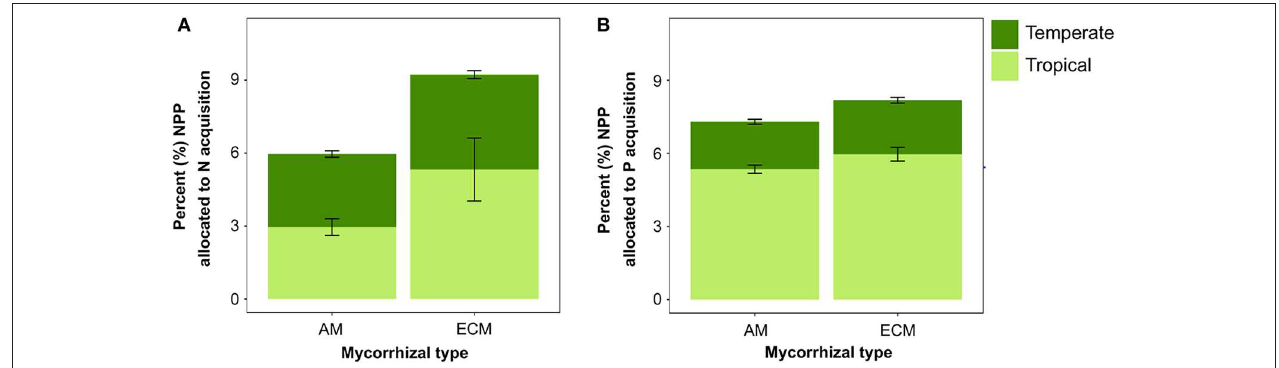
FIGURE 6 | Percent (mean ± SE) of NPP allocated to modeled (A) N and (B) P acquisition across temperate ( n = 45) and tropical ( n = 18) forest sites when mycorrhizal association is prescribed as either all AM or all